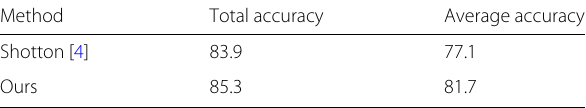
Table 2 Performance comparison of scene-level labeling on